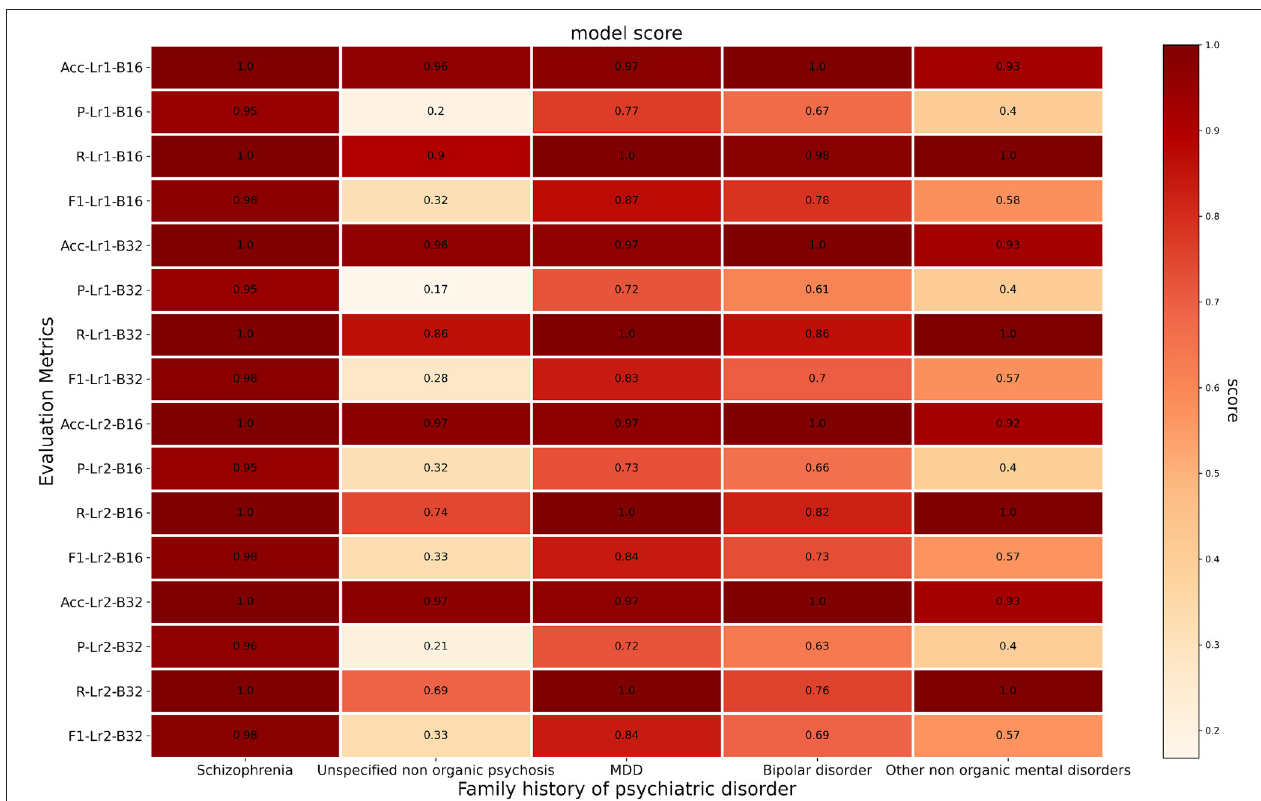
FIGURE 3 | Heatmap representation of disorder extraction scores from different evaluation metrics. Acc, accuracy; P, precision; R, recall; Lr1, learning rate = 1e-4; Lr2, learning rate = 1e-5; B16, batch size = 16; B32, batch size = 32.